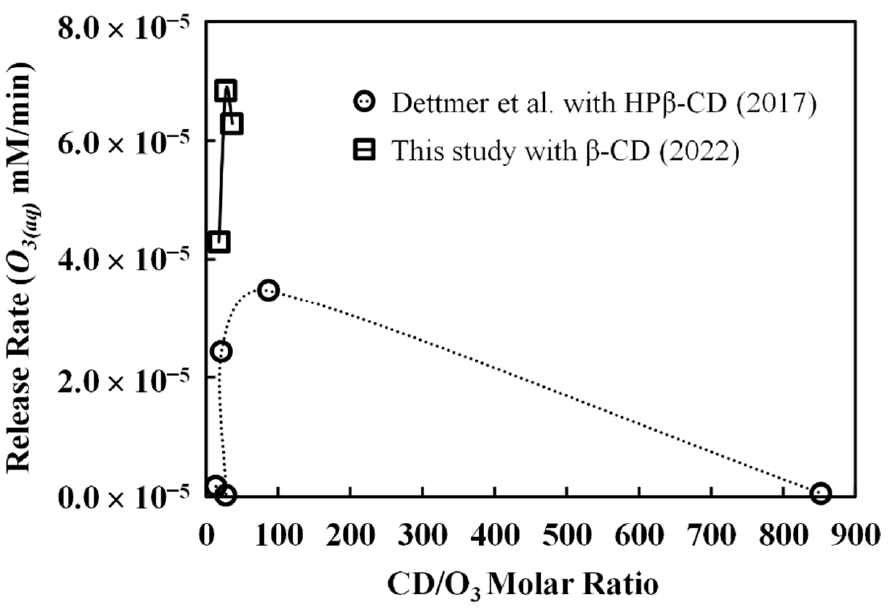
Figure 8. Comparisons of ozone release rates from this study and the study by Dettmer et al. [14] .